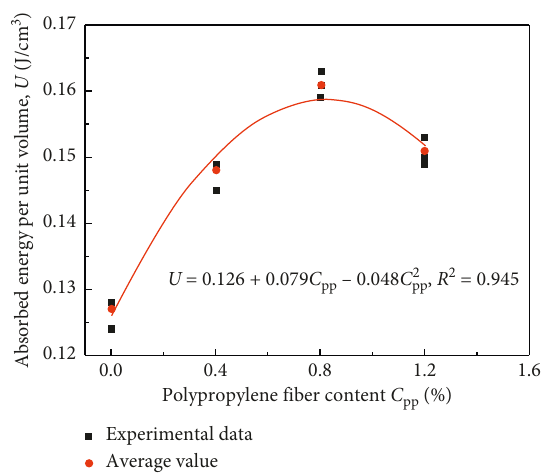
Figure 13: Relationship between absorbed energy per unit volume and polypropylene fiber content.